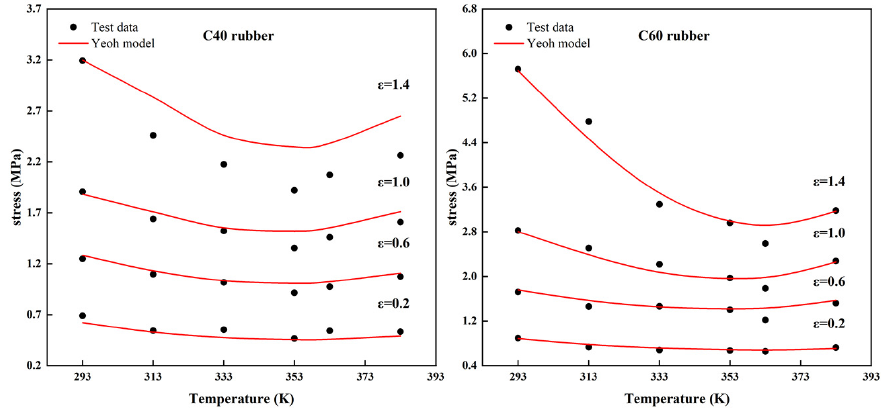
Figure 8. Stress–temperature curves of four types of rubber specimens at different constant elongation strains and the prediction curves of the Yeoh constitutive model with explicit temperature pa- rameters.